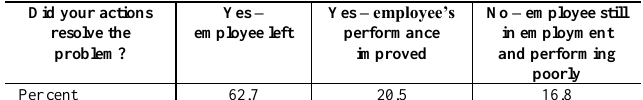
Table 6: Outcome of selection error Did your actions resolve the problem?